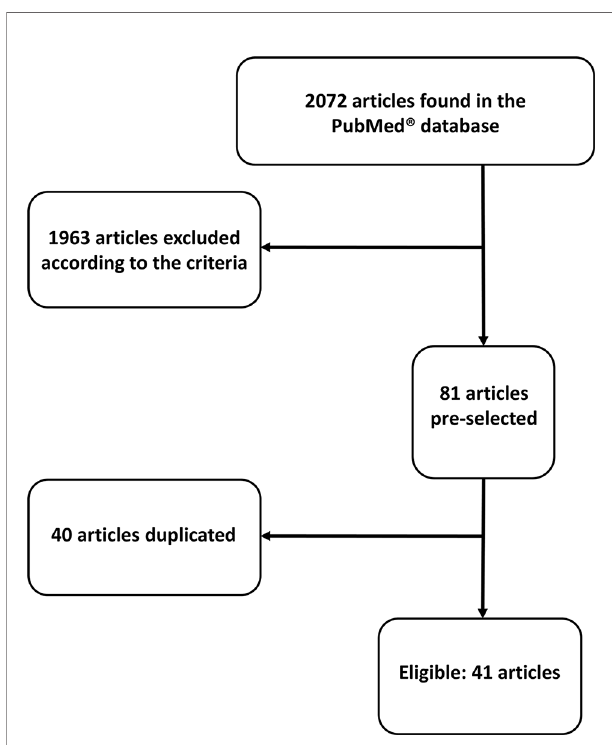
FIGURE 1 | Flow chart showing search